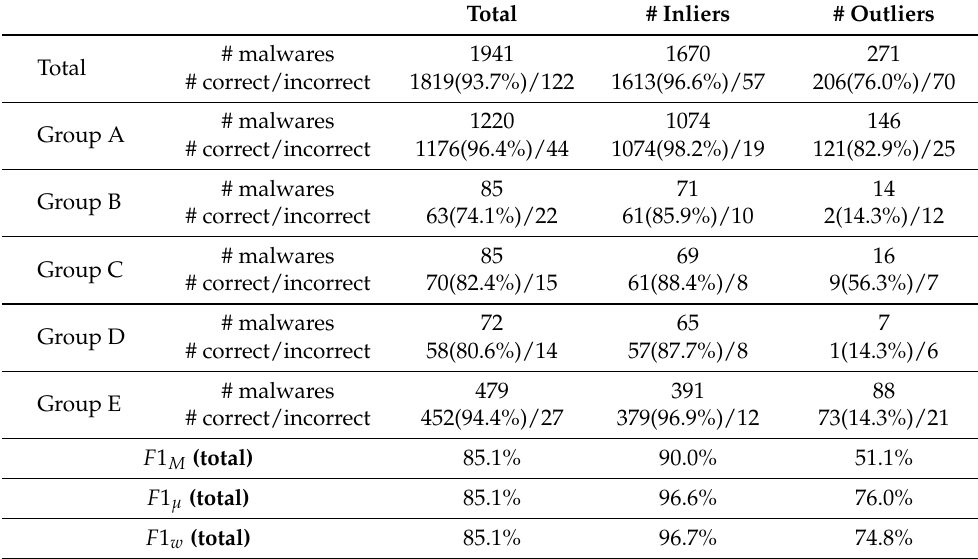
Table 1. Effectiveness of inter-class